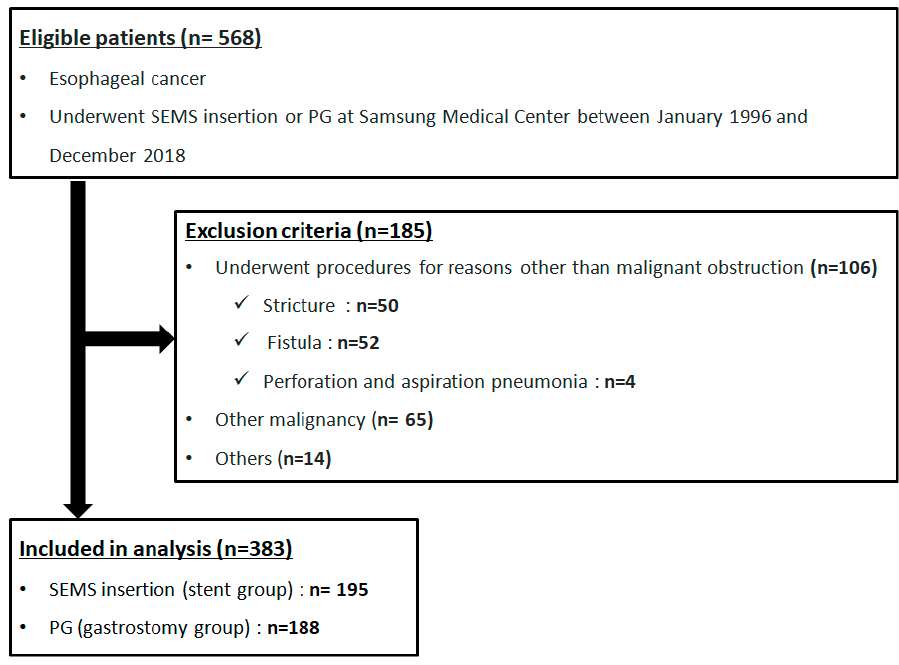
Figure 1. Flow chart of the study population. SEMS, self-expandable metal stent; PG, percutaneous gastrostomy.